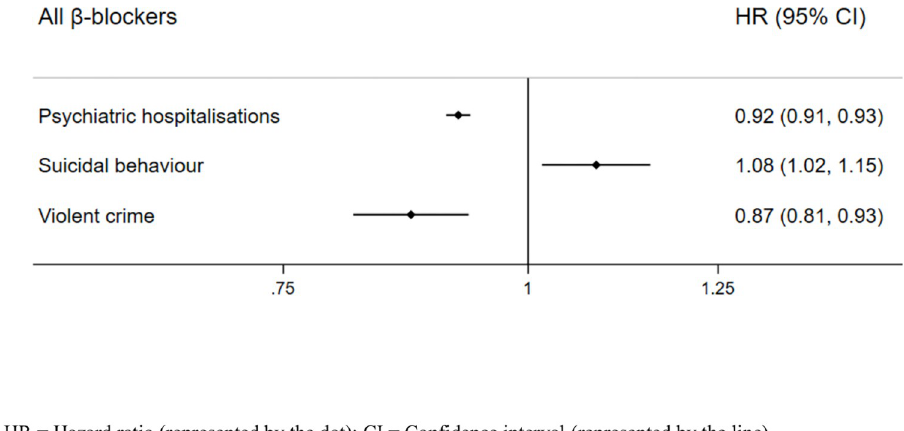
Fig 1. Age-adjusted within-individual associations between β -blockers and psychiatric and behavioural outcomes in the β -blockers cohort ( n = 1,400,766). CI, confidence interval; HR, hazard ratio.